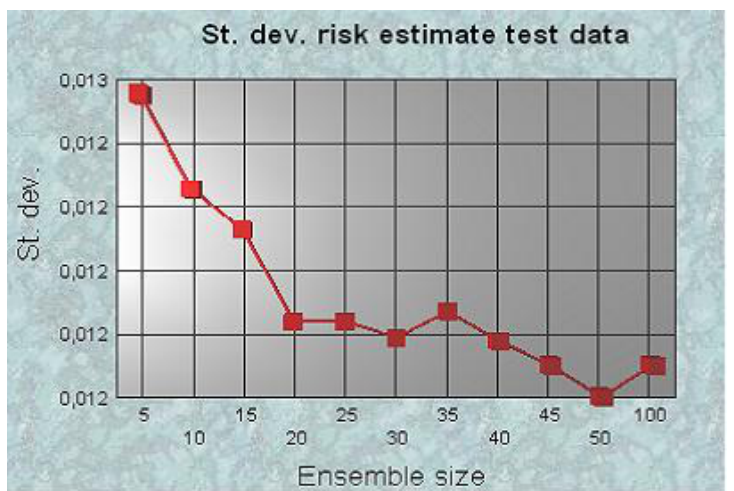
Figure 4: Relationship between ensemble size and standard deviation of risk estimate for test data